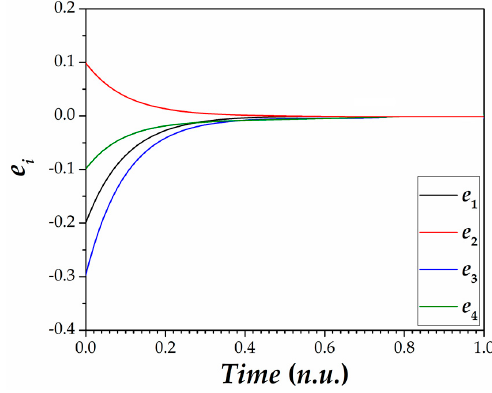
Figure 9. Time-series of the synchronization errors e i ( t ), ( i = 1, 2, 3, 4).